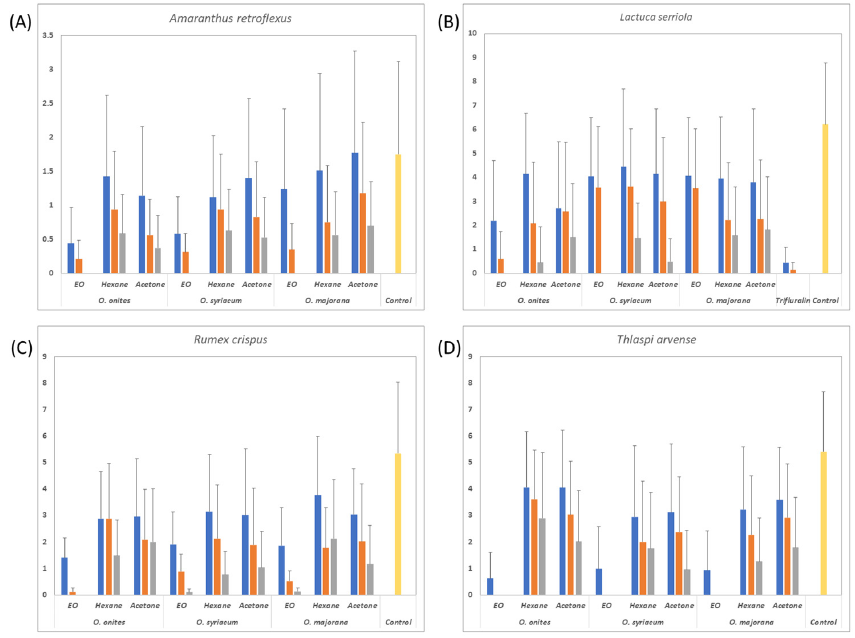
Figure 2. The root development of the weeds (cm). ( A ) Amaranthus retroflexus , ( B ) Lactuca serriola , ( C ) Rumex crispus , ( D ) Thlaspi arvense . Blue bars indicate 5 µL dose application while red bars 10 µL, grey bars 20 µL. The yellow bars indicate control application.